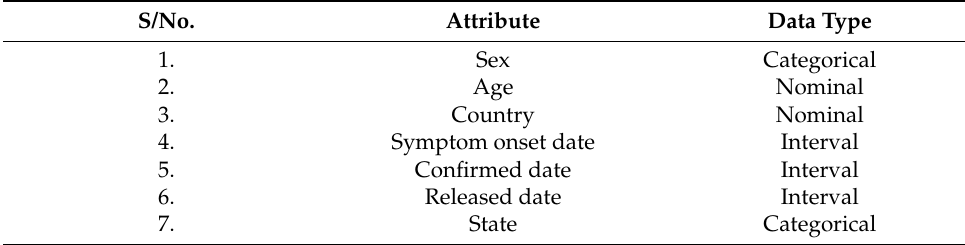
Table 1. Description of COVID-19 infection